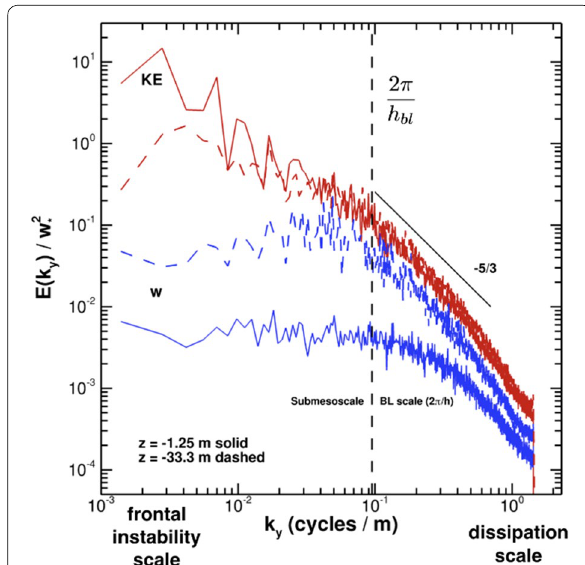
Fig. 12 Filament spectrum during frontal arrest. The associated along-front horizontal-wavenumber k y spectrum of turbulent kinetic energy E ( k ) and its vertical-velocity w component in the center of the filament at the time of frontal arrest ( t = 6 h; Sullivan and McWilliams 2018). The spectrum peak is associated with a lateral shear instability whose eddy momentum flux, � u ′ v ′ � , arrests the frontogenesis by the mean secondary circulation. It is accompanied by a forward cascade of energy to microscale dissipation with a characteristic spectrum 5 / 3 slope ∝ k − y